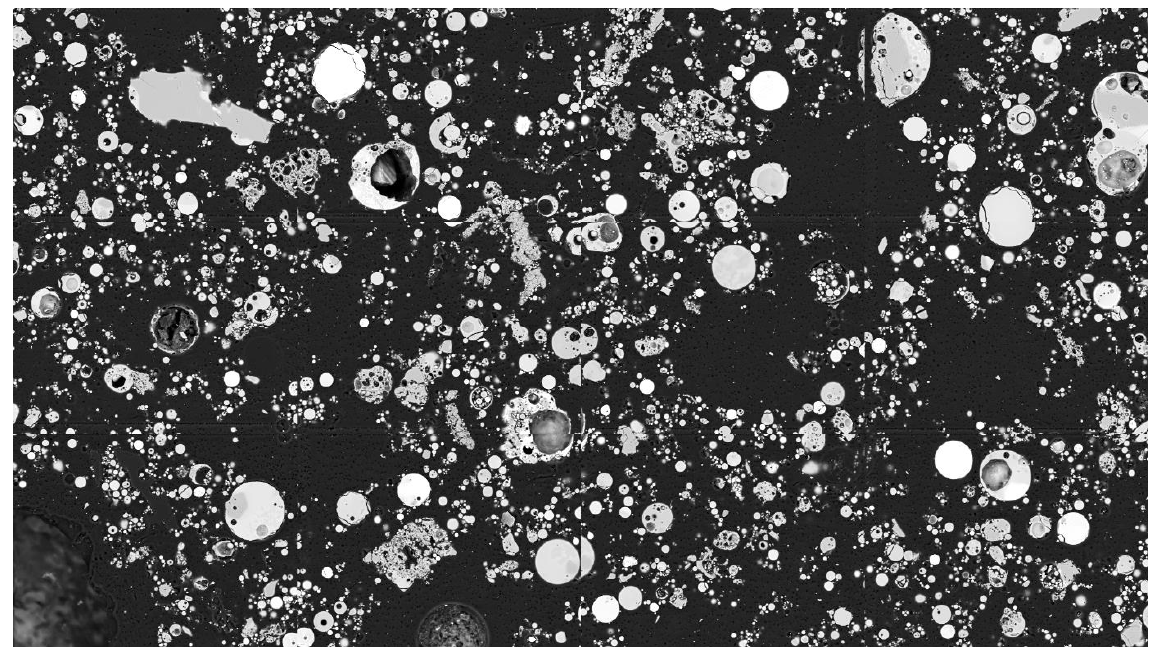
Figure 10. Large-area BSE image of a polished section of an epoxy-impregnated unreacted FA (the number of acquired fields was 12). The image width is 1024 μm.